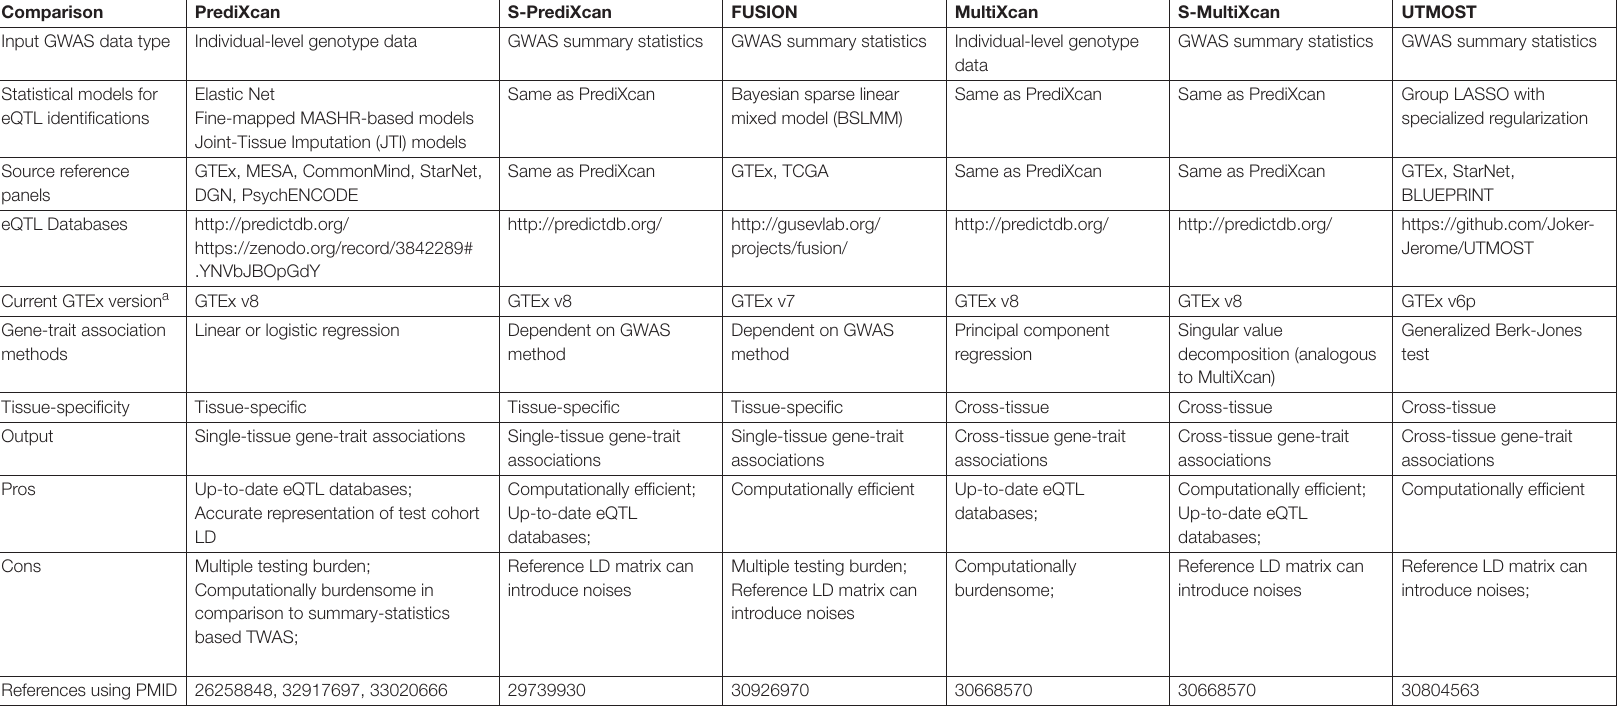
TABLE 2 | Summary of TWAS methods.